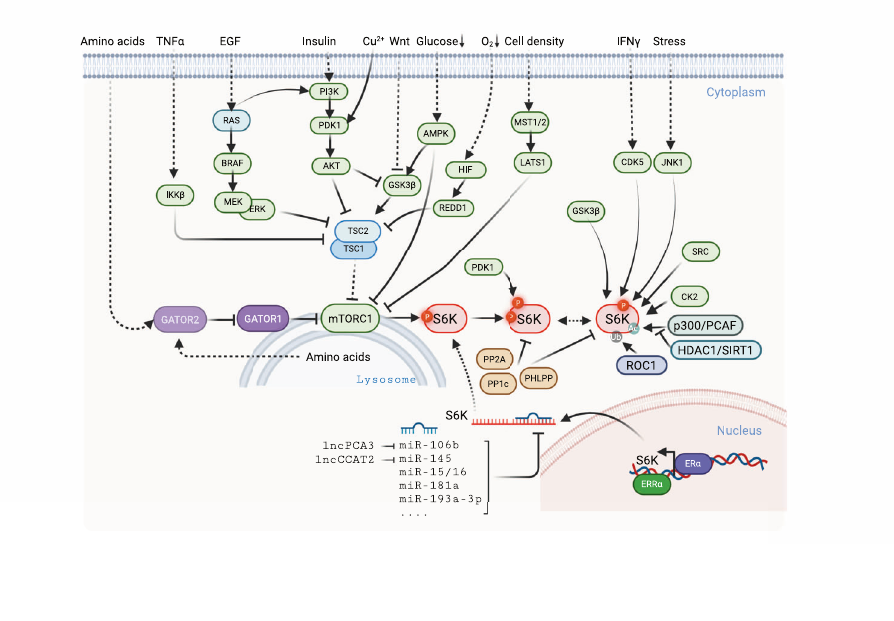
Fig. 2 Upstream regulators of S6K. At the mRNA level, after transcription by ER α and ERR α , S6K mRNAs undergo miRNA-mediated degradation. At the protein level, several kinases are responsible for the release of the autoinhibitory domain of S6Ks, which enables accessibility for mTORC1 and PDK1. Upon various stimuli, including amino acids, cytokines, and metal ions, TSC1/2 lose the ability to suppress mTORC1 activity. Along with phosphorylation by mTORC1, PDK1 induces phosphorylation of S6Ks and results in its full activation. In contrast, phosphatases, including PP2A, account for the dephosphorylation of S6Ks. In addition, S6Ks are subject to ubiquitination and acetylation by ROC1 and P300/PCAF,